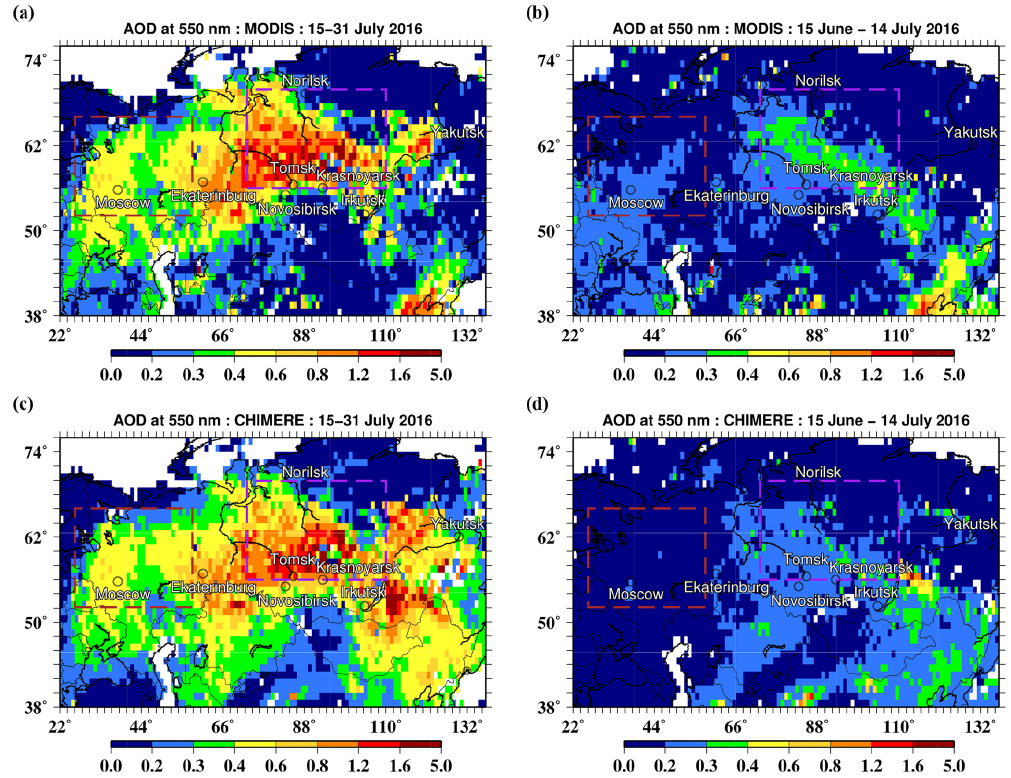
Figure 2. Spatial distributions of the temporal averages of AOD (at 550nm) in the periods (a, c) from 15 to 31 July 2016 and (b, d) from 15 June to 14 July 2016 according to (a, b) the MODIS observations and (c, d) the combined CHIMERE simulations for the bb_vbs and bgr scenarios. The distributions represent the ancillary sets of AOD data that were selected irrespective of the availability of the corresponding AAOD retrievals. The rectangles depict the source (purple lines) and receptor (dark red lines) regions covering parts of Siberia and (mostly) the European territory of Russia,